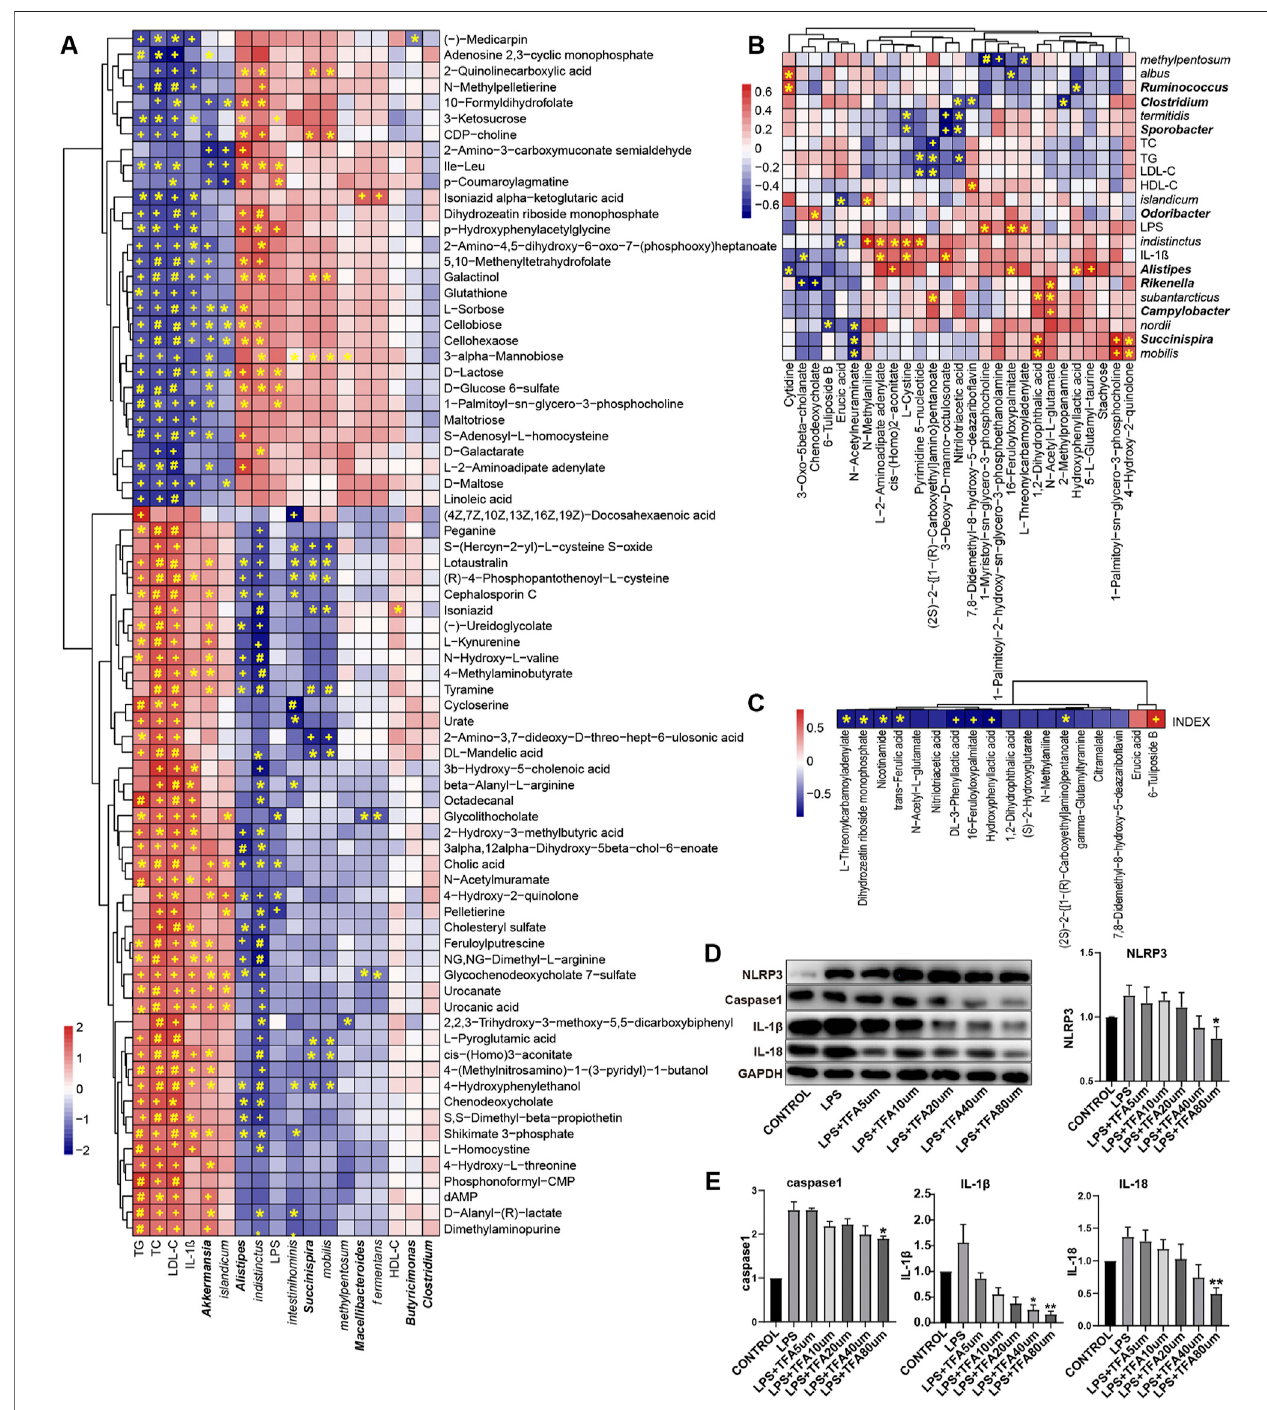
FIGURE6| Thesigni fi cantchangesinmetabolicpro fi lesofgutmicrobiotainhighcholesteroldietandTXLtreatmentrabbits (A) HeatmapofSpearmancorrelations between the most abundant bacteria whose abundances signi fi cantly changed and serum factors in HCB rabbits and the most abundant metabolites with important functions and signi fi cant differences. n = 9. (B) Heatmap of Spearman correlations between the most abundant bacteria whose abundances signi fi cantly changed and serumfactorsinHCB+TXL12wrabbitsandthemostabundantmetaboliteswithimportantfunctionsandsigni fi cantdifferences.n=10 (C) HeatmapofSpearman correlations between the plaque vulnerability index and the most abundant metabolites with important functions and signi fi cant differences. n = 10.The color bar with numbers indicates the correlation coef fi cients. Row names thickened represent bacteria genus, otherwise represent bacteria species. r: the spearman correlation coef fi cient; p: statistical signi fi cance. Adj: adjusted. T-test adjusted by Benjamini Hochberg procedure to control FDR < 5% (A, B, C) were used for statistical tests. At FDR < 5%, *: FDR-adjusted p < 0.05; +: FDR-adjusted p < 0.01; #: FDR-adjusted p < 0.001. (D,E) Western blotting to quantitate NLRP3/Caspase-1/IL-1 β /IL-18 protein expression, all groups were stimulated by LPS except the CONTROL group, and non-parametric test was used for statistical, data were shown as the mean ± S. E. M. The horizontal note number represents the concentration of trans-ferulic acid. *: p < 0.05; **: p < 0.01.